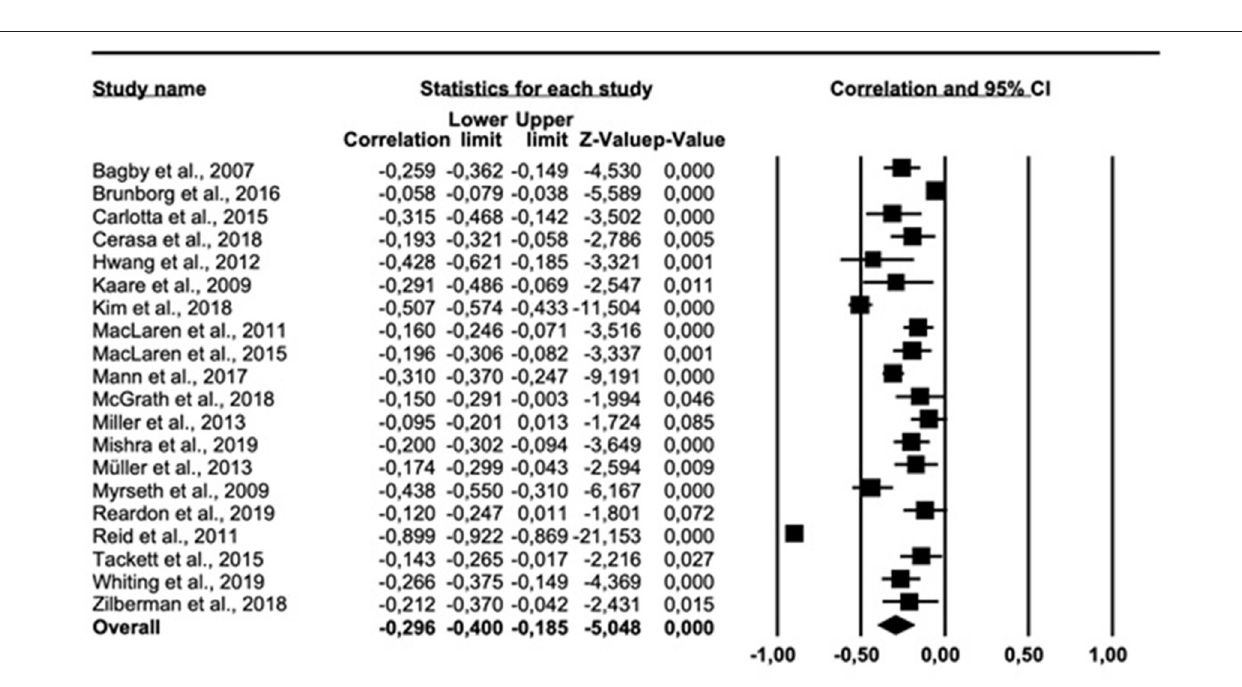
FIGURE 3 | Forest plot showing the relationship between gambling problems and